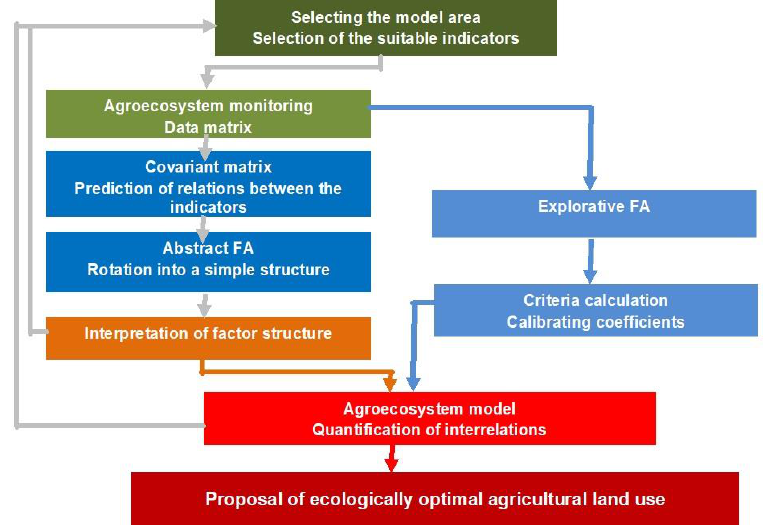
Figure 4. Schematic model of factor analysis.